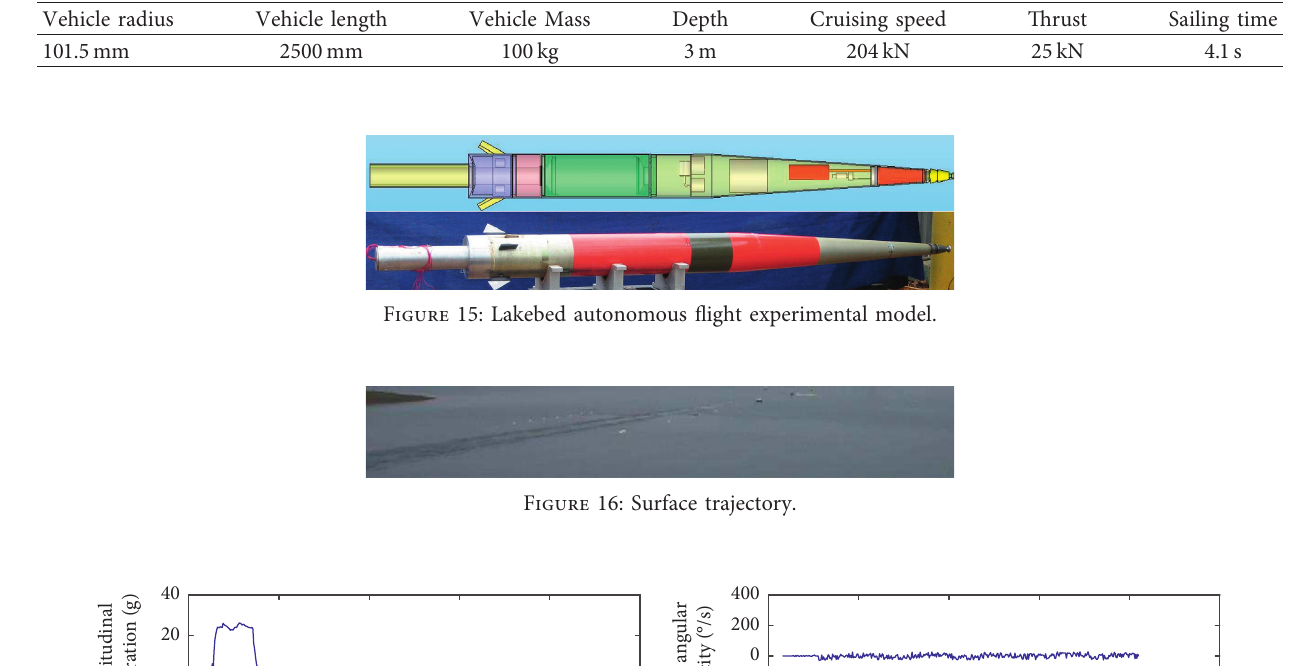
Table 3: Parameters in autonomous flight experiments.